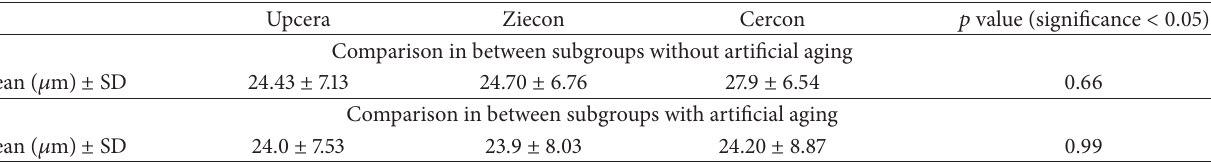
Table 5: Comparison of shear bond strength (MPa) in all the groups showing mean, standard deviation, and significance for the samples within subgroups.